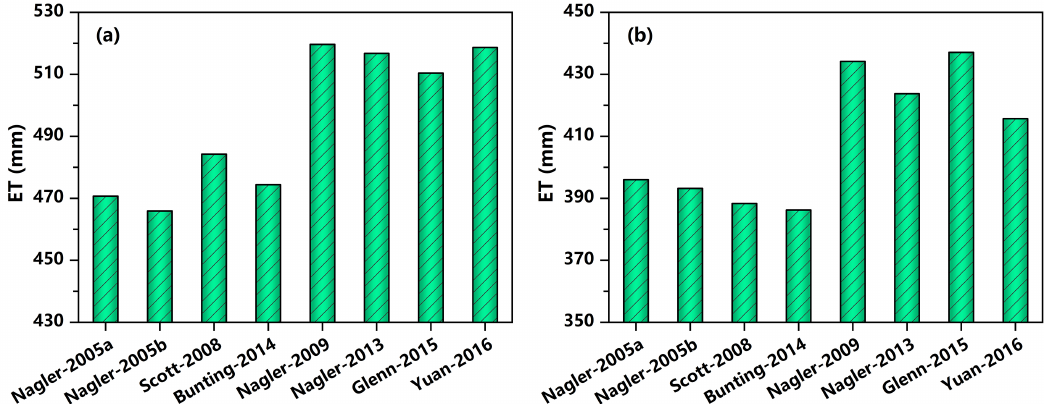
Figure 7. Variability of the mean monthly ET for the growing season from 2013 to 2018, estimated by the eight ERSETMs for the Tamarix site ( a ) and the Populus site ( b ).